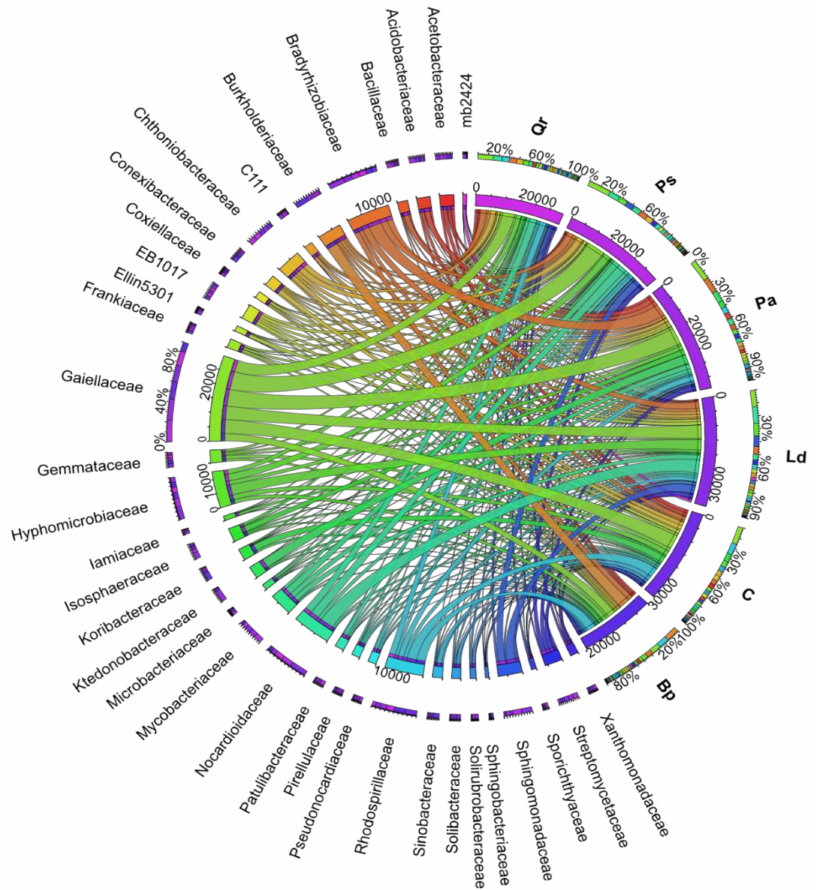
Figure 7. The relative abundance of the dominant families’ bacteria in forest soils with the difference between the proportions ≥ 1%. The operational taxonomic unit (OTU) values of families’ bacteria provide data in direct proportion to the width of each band connecting the bacterial taxa to the respective soil sample. A specific color is assigned to each family of bacteria. The inner ring represents the number of 16S amplicon sequences assigned to a given taxon, while the outer ring represents the total percentage of 16S sequences. C—non-afforested land, Pa— Picea abies L., Ps— Pinus sylvestris L., Ld— Larix decidua M., Qr— Quercus robur L., and Bp— Betula pendula